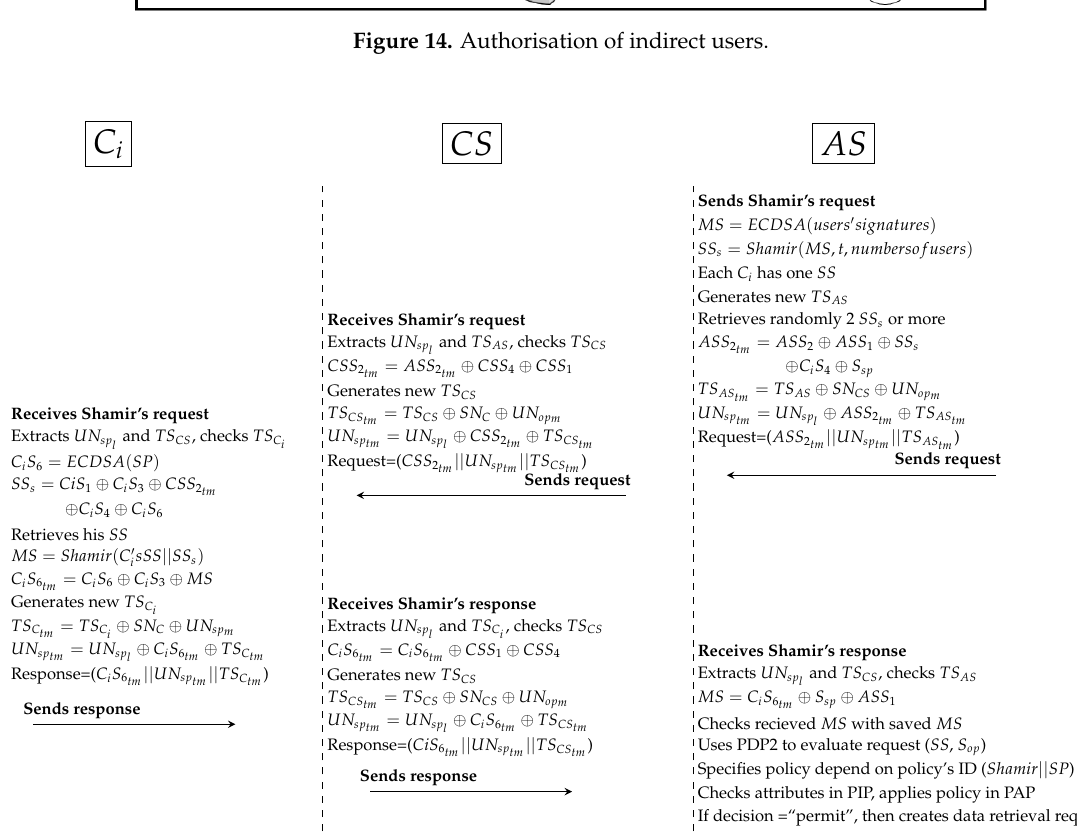
Figure 14. Authorisation of indirect users.